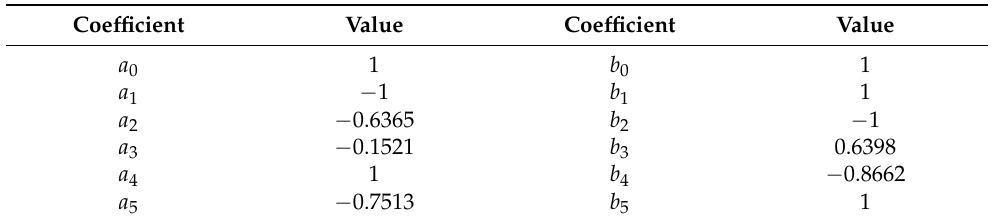
Table 5. Coefficients obtained for a 5th order polynomial model by means of the Jaya algorithm using the 8-point sample.